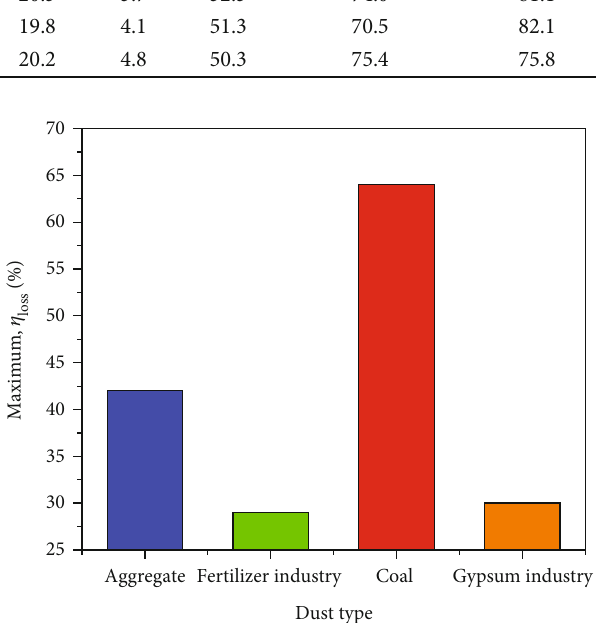
Figure 9: Maximum e ffi ciency loss basing on dust with particle size 20-45 μ